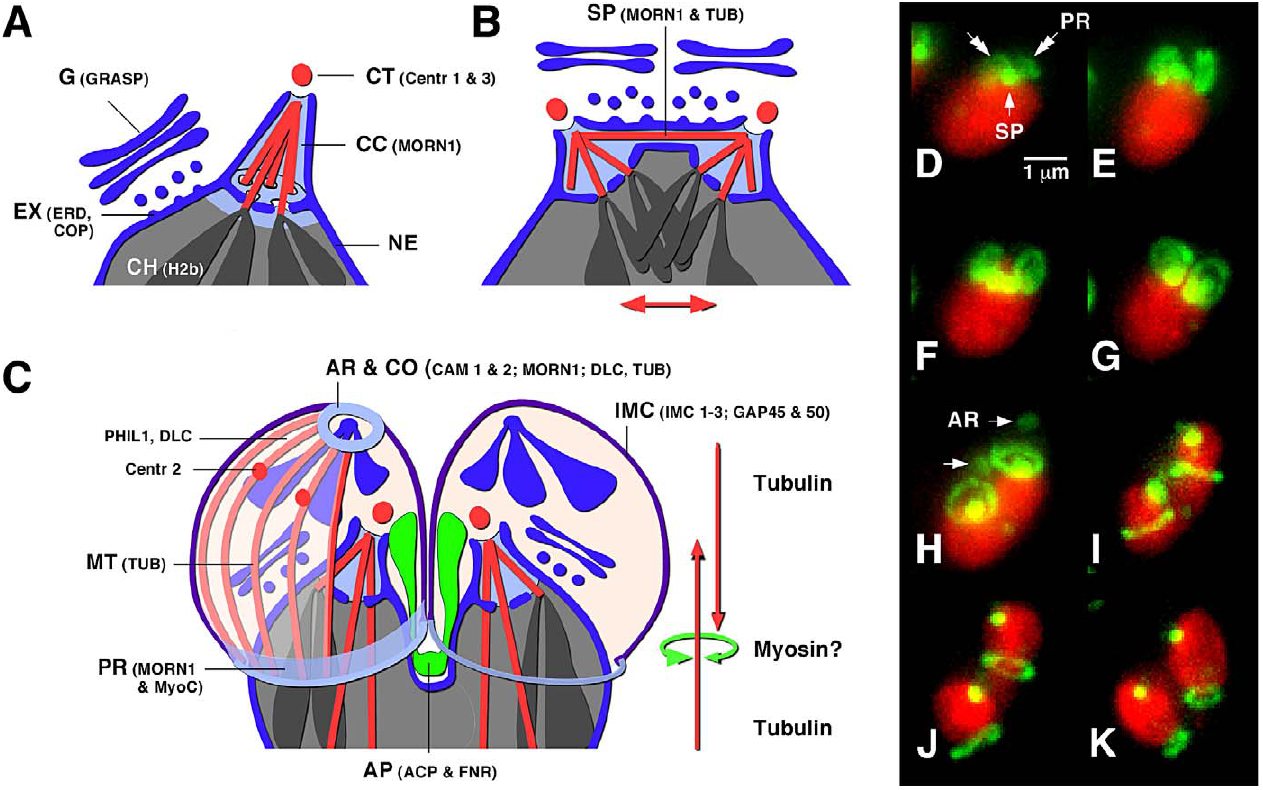
Figure 4. The Mechanics of Apicomplexan Mitosis and Budding (A–C) Schematic representation of the nucleus during interphase (A), mitosis (B), and mid-stage budding (C). Smaller type abbreviations refer to organelle-specific marker proteins in T. gondii (most are available as fluorescent protein in vivo tags, see text for further details and references). AP, apicoplast; AR, apical rings; CC, centrocone; CH, chromosome; CO, conoid; CT, centromere; EX, ER exit site; MT, subpellicular microtubule; NE, nuclear envelope; PR, posterior ring; SP, spindle. (D–K) Time lapse series of nuclear division in T. gondii reproduced from [32]. The nucleus is labeled in red (Histone H2b-RFP) and MORN1 in green (MORN1-YFP).